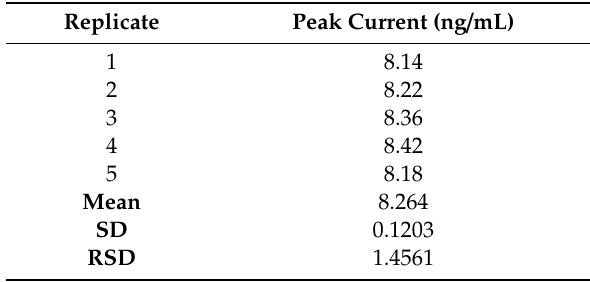
Table 2. Reproducibility of 100 ng / mL of CFP10–ESAT6